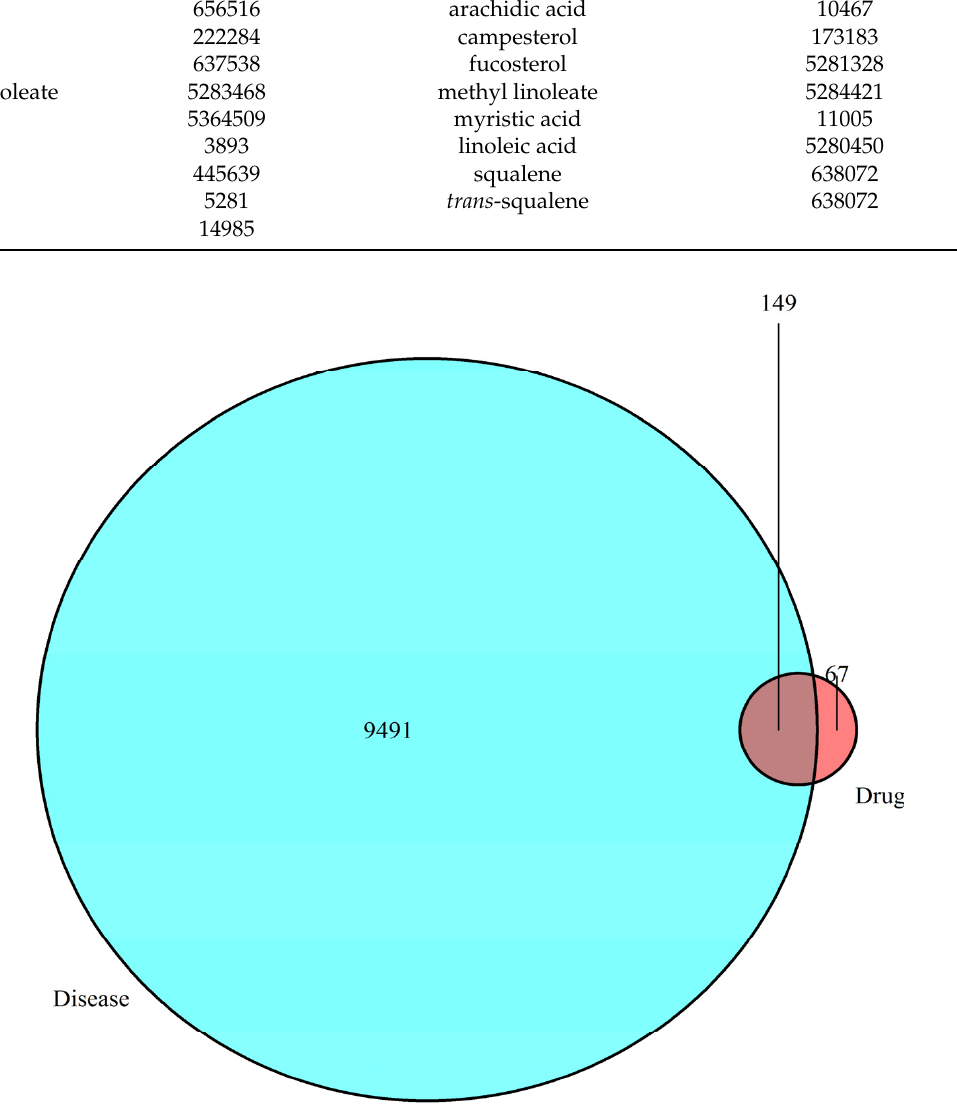
Figure 3. Venn Figure 3. Venn diagram.